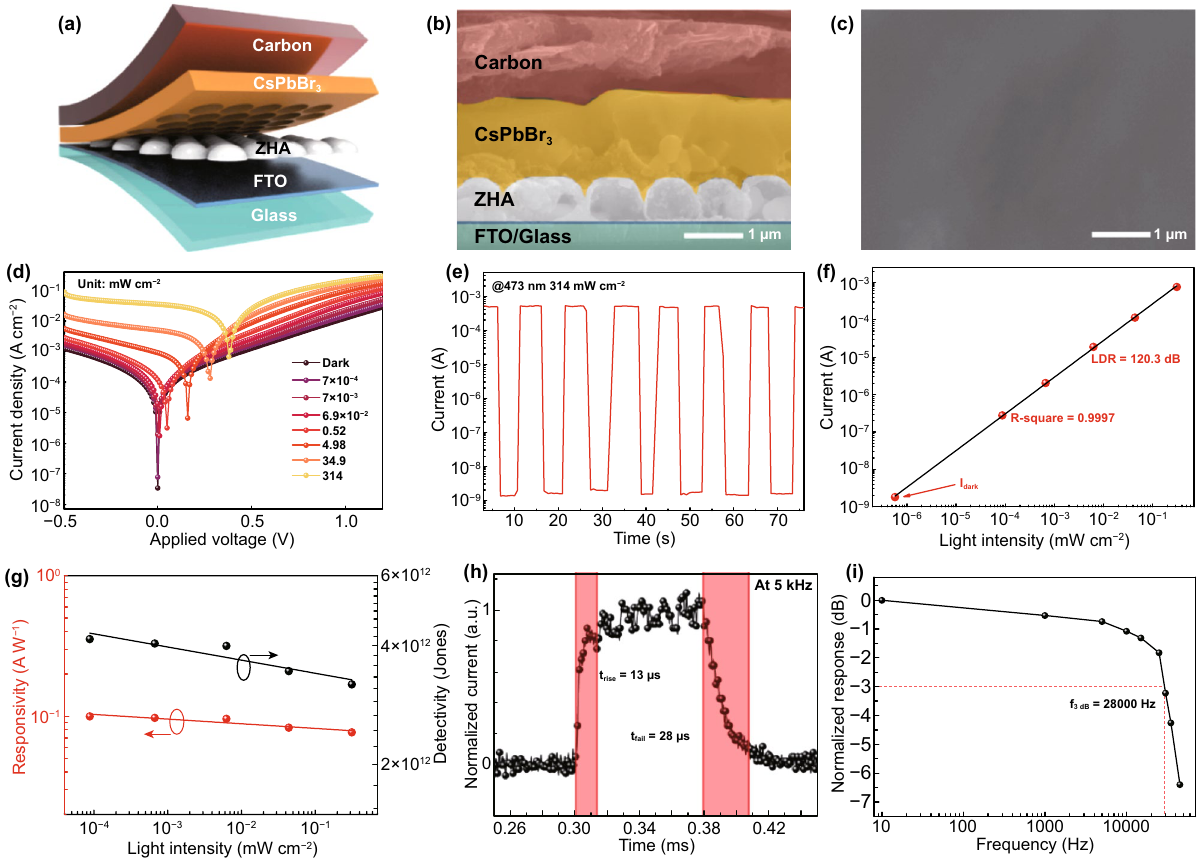
Fig. 4 a Structure diagram of the ZHA/CsPbBr 3 PD. b Cross-sectional SEM image of the PD. c Top-view SEM image of the CsPbBr 3 layer pre- pared on the ZHAs. d J–V curves under different light intensities. e I–t curve under the light intensity of 314 mW cm −2 . f LDR curve. g Respon- sivity and detectivity. h Response time and i f −3db of the ZHA/CsPbBr 3